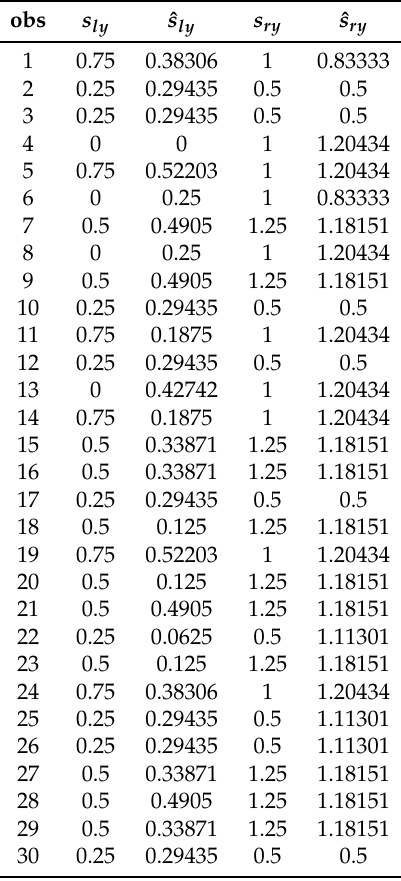
Table 3. The predicted spreads based on the inverse F